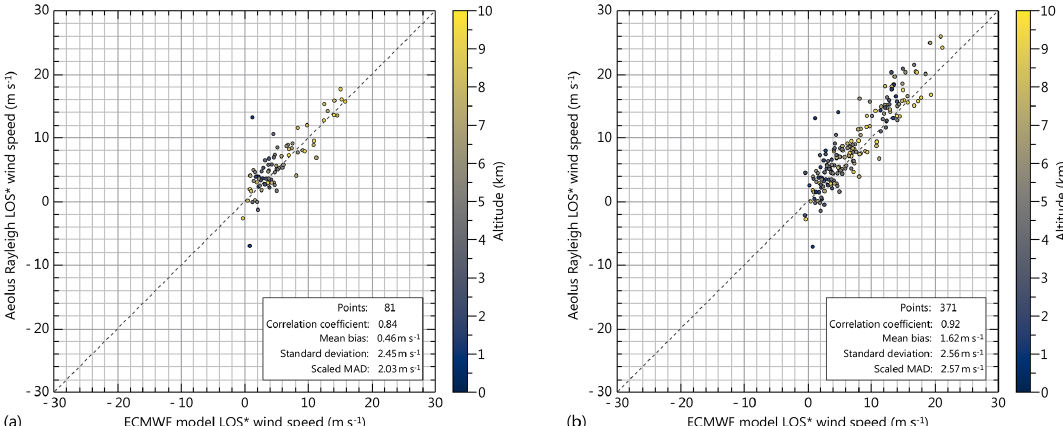
Figure 11. Scatterplots comparing the Aeolus L2B Rayleigh LOS* winds with the ECMWF model LOS* winds (a) for the wind scene on 22 November 2018 between 16:13 and 17:15UTC and (b) for all of the underflights from the WindVal III campaign. The data points are colour-coded with respect to the bottom altitude of the respective bins used for comparison.